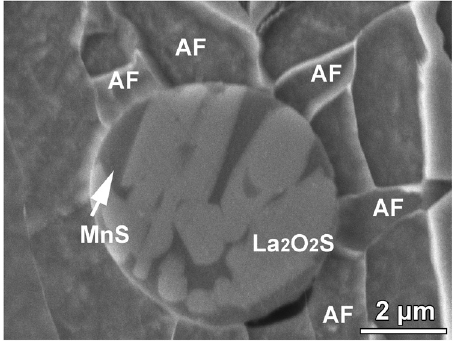
Figure 8: The typical nucleation of AF on the inclusion in steel no.